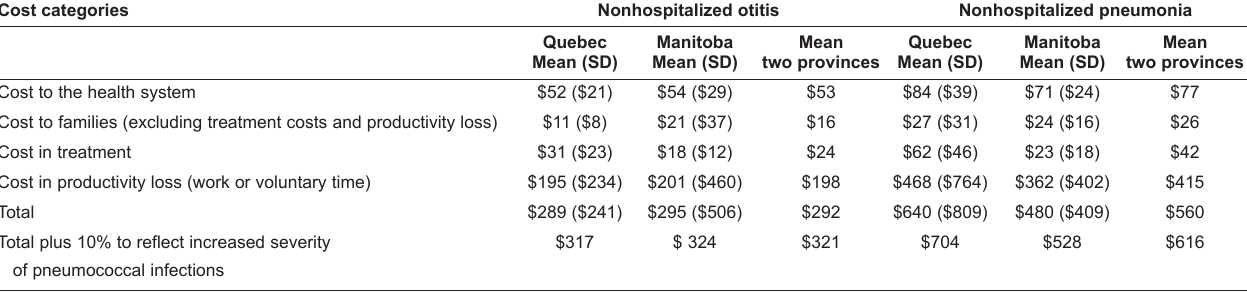
TABLE 3 Unit costs of non-hospitalized otitis and pneumonia by cost category in two Canadian provinces Cost